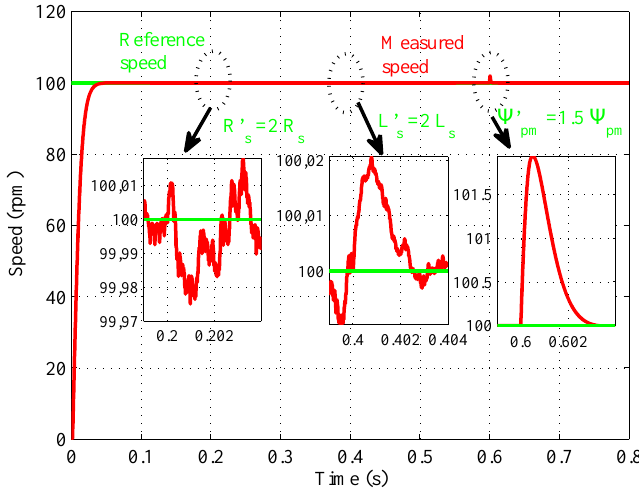
Figure 7. Speed reponse with parameters variations.